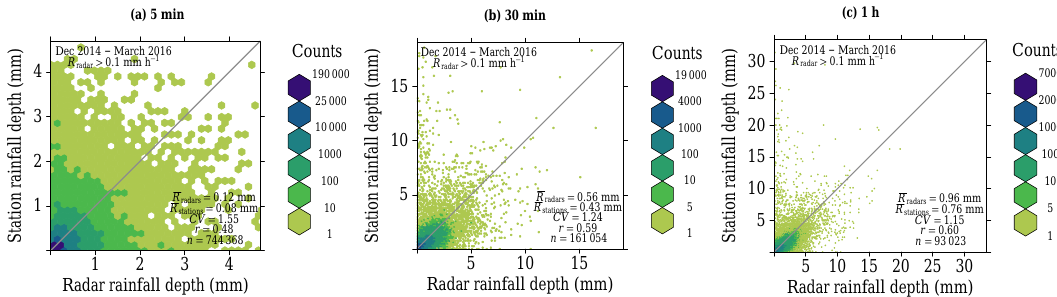
Figure 8. Scatter density plots of all station rainfall measurements against the gauge-adjusted radar rainfall data in the corresponding radar pixel when radar reported non-zero rainfall ( > 0.1mm). The R radars , R stations , CV, r and n values in the panels represent the average rainfall according to the gauge-adjusted radar data, the average rainfall according to the stations, the coefficient of variation of the residuals, the correlation and the number of intervals, respectively. Graphs are made for 5min, 30min and hourly accumulation intervals.